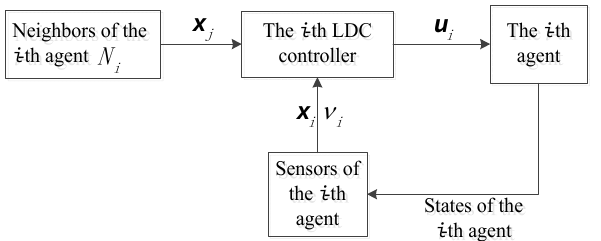
Figure 2. Control principle block-diagram of the presented LDC